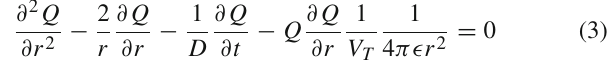
Fig. 1 Weighting field E ω for a cross section of the three geometries used in current and future 0 νββ experiments: (from left) PPC, BEGe and inverted coaxial. The thick black and gray lines are the p + and n + electrode, respectively. The yellow points are locations of an energy